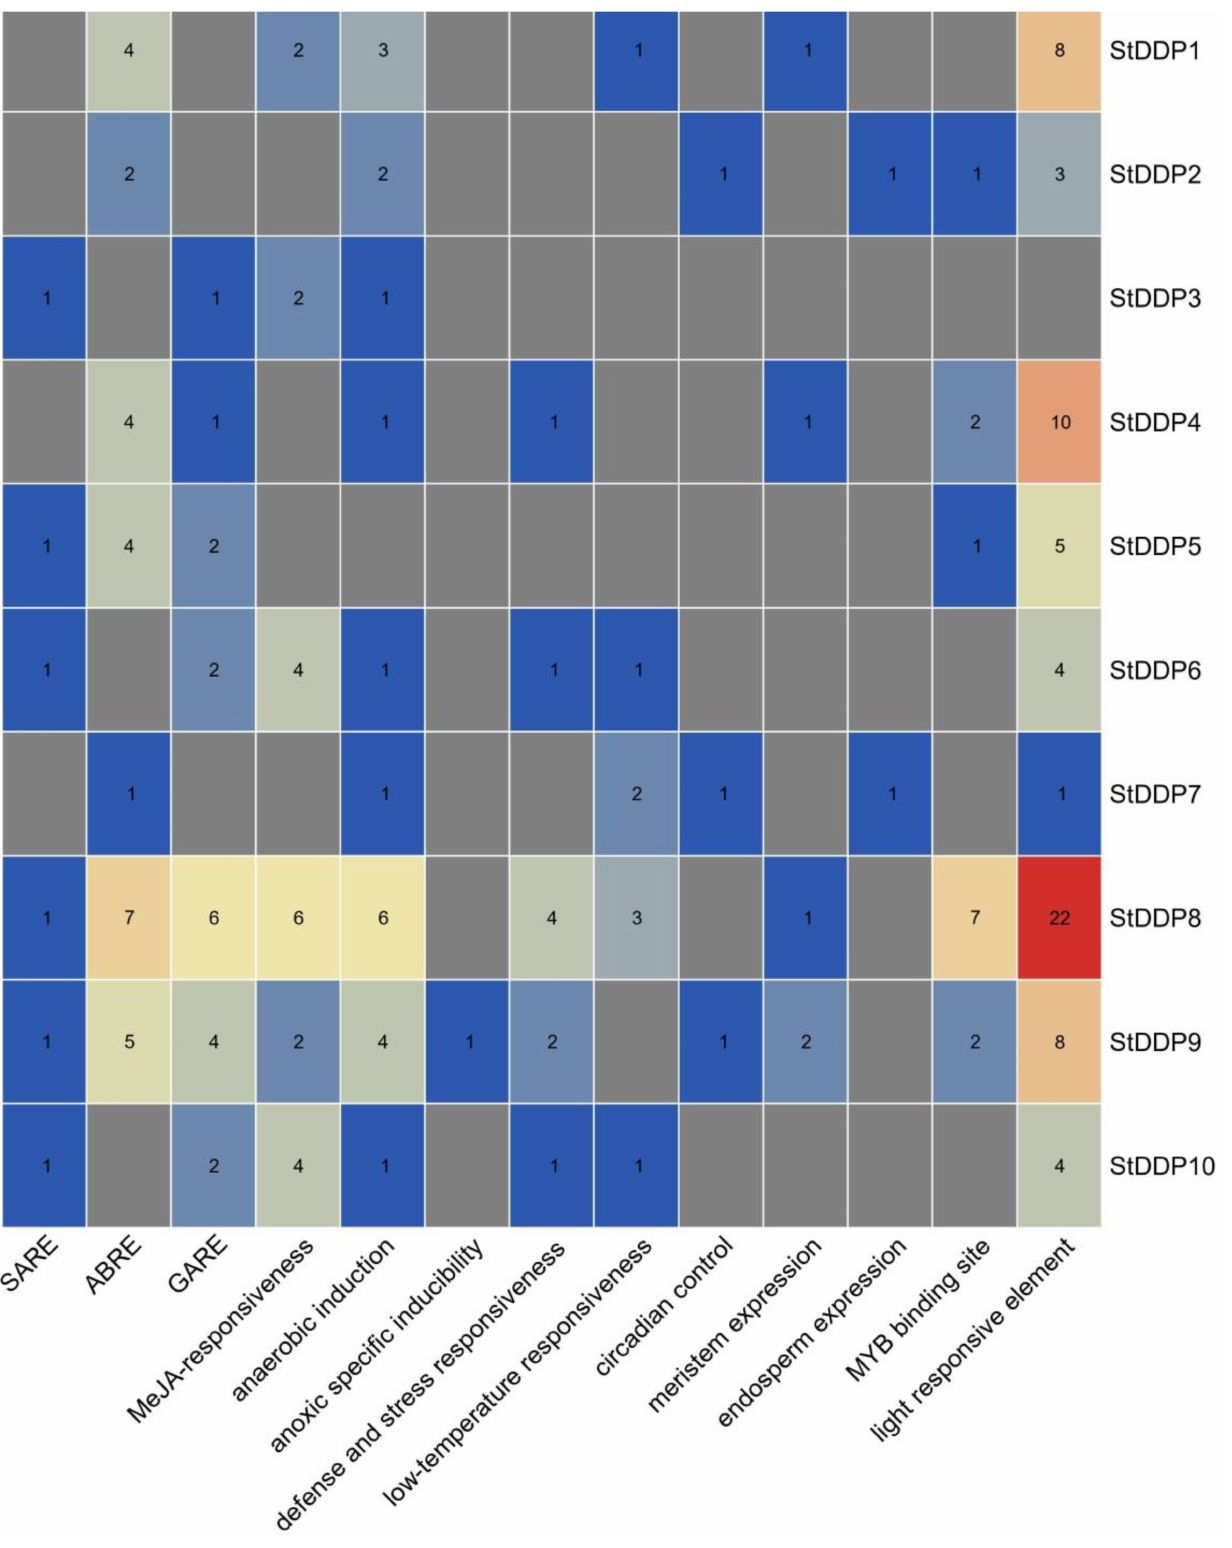
Frontiers in Plant Science |